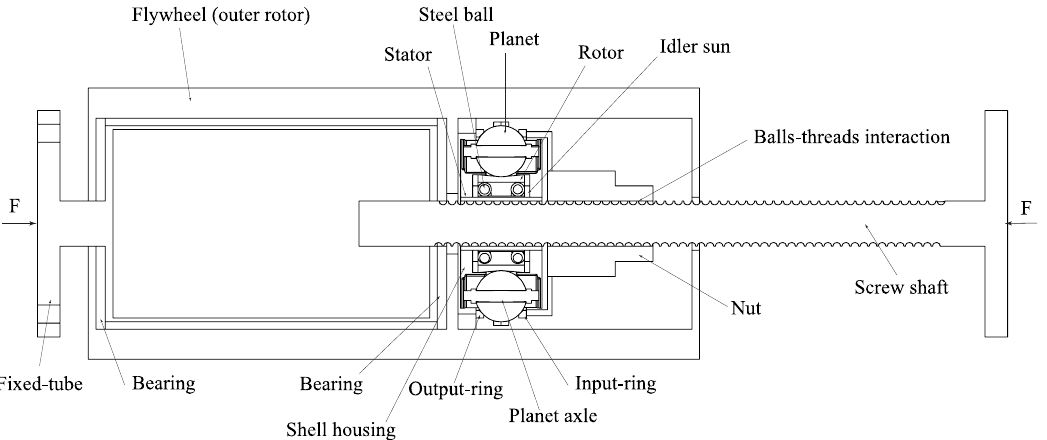
Figure 2. Symbolic representation and principal components of adaptive inertance damper (AID).